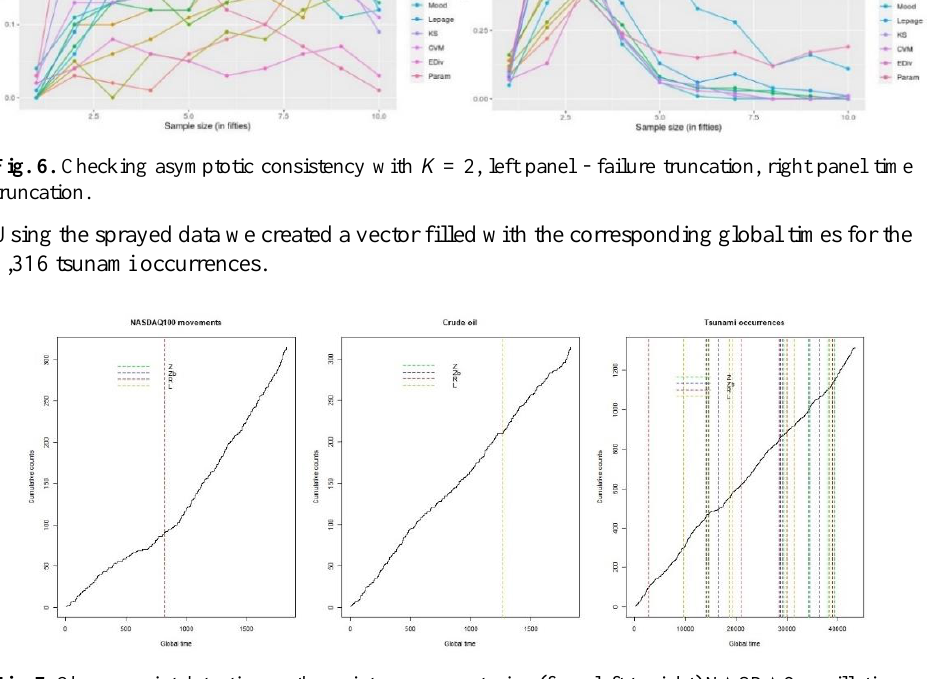
Fig. 7. Change point detection on the point processes storing (from left to right) NASDAQ oscillations, crude oil price fluctuations, and tsunami